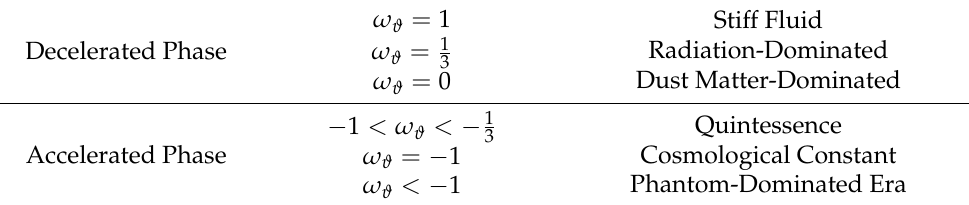
Table 1. The different phases of equation of state (EoS)